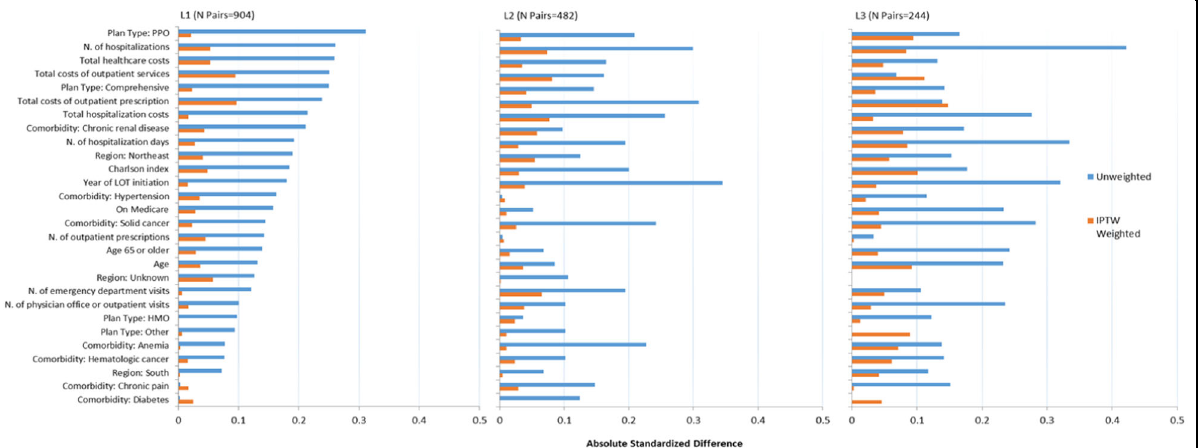
Fig. 3 Standardized Differences in Patient Characteristics. Differences among patients with versus without progression based on unweighted and sIPTW analyses by LOT (unweighted standardized difference 0.1 or more in any